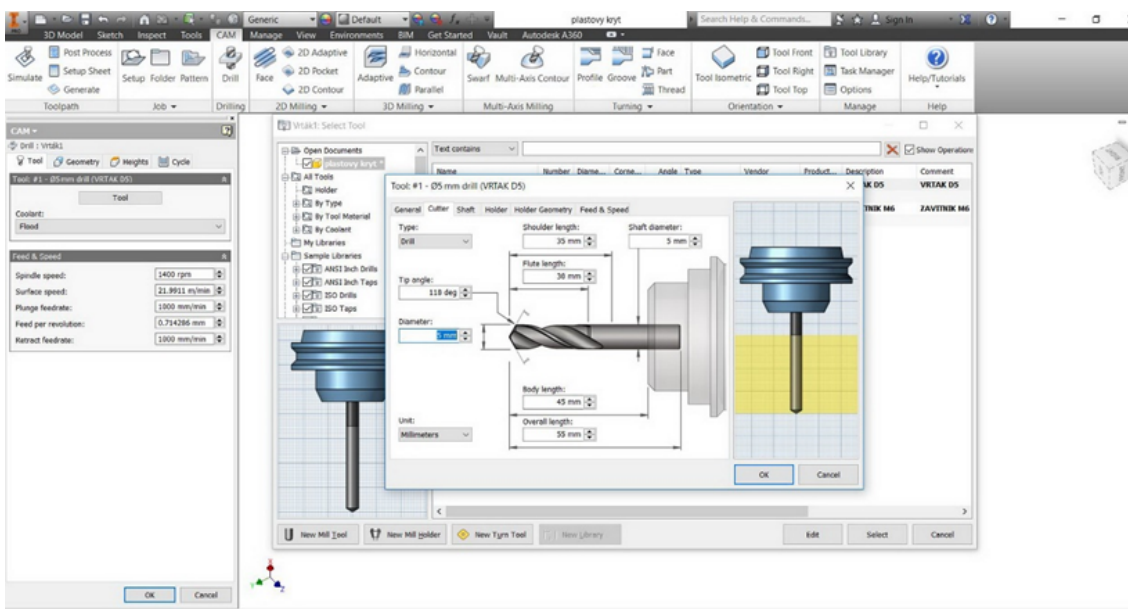
Figure 8: Selection of drill and cutting conditions for 5 mm hole production.